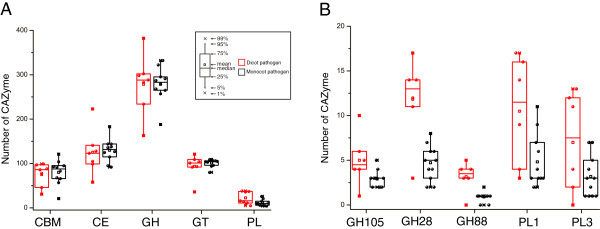
Comparison of CAZymes among fungi pathogenic to monocots and dicots. (A) The number of members in each CAZyme class and CBMs in the predicted proteomes were plotted for fungi that infect dicots (red dots) or monocots (black dots). (B) The number of CAZymes which showed obvious differentiation among fungi that infect dicots or monocots. Dicot pathogens have more pectinases from families GH28 (P < 0.01), GH88 (P < 0.01) and GH105 (P < 0.01) than fungi pathogenic to monocots. Although the significance of the comparison was not supported by the t test (P > 0.05), some dicot pathogens tend to have much more PL1 and PL3 enzymes than monocot pathogens. See Figure 1 for abbreviations.